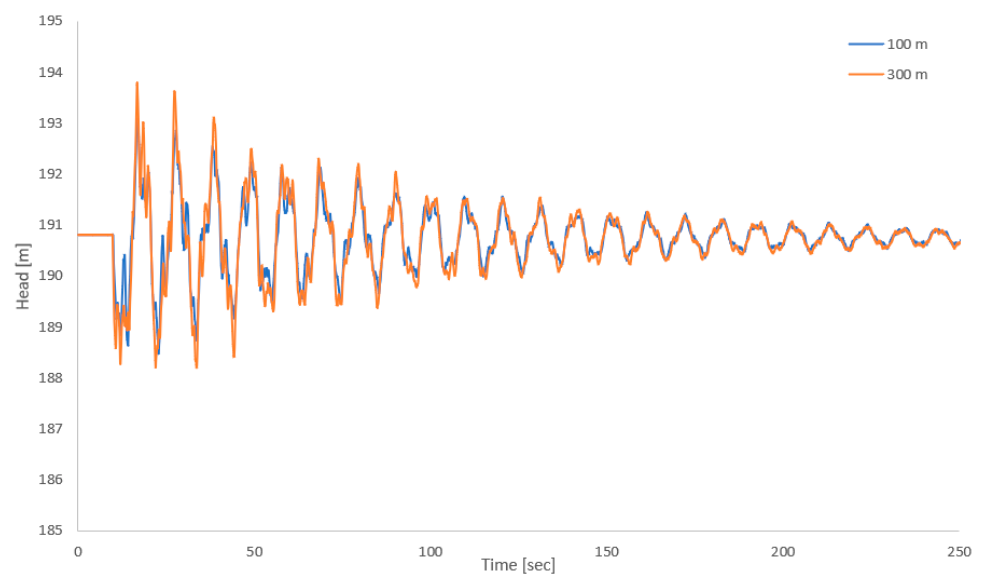
Figure 1. Two leaks located on the same pipe as seen from a neighbor node.